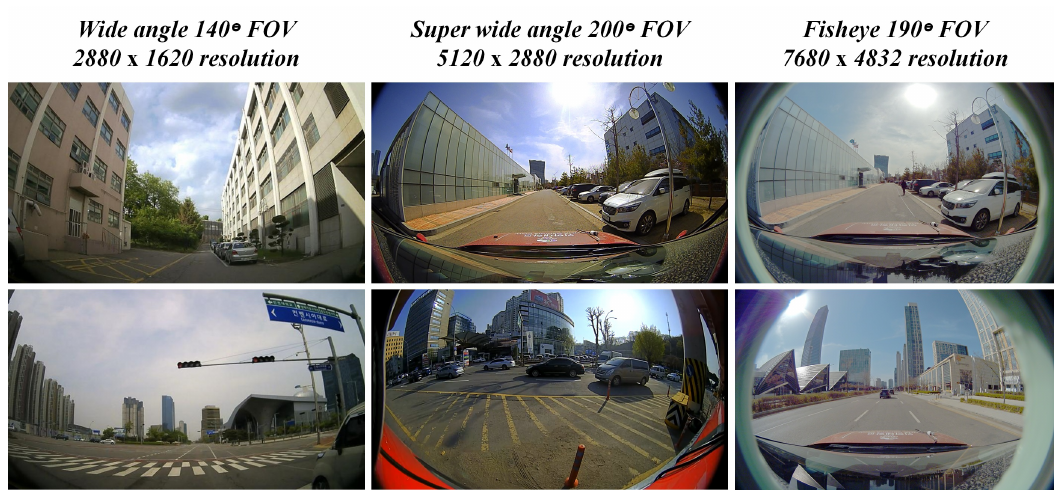
Figure 8. High-Resolution acquisitions of real-time data samples from larger FOV cameras.